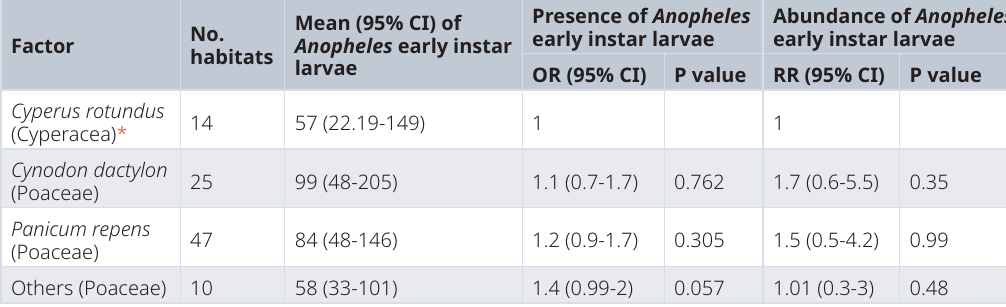
Presence of Anopheles early instar larvae OR (95% CI) P value RR (95% CI) P value